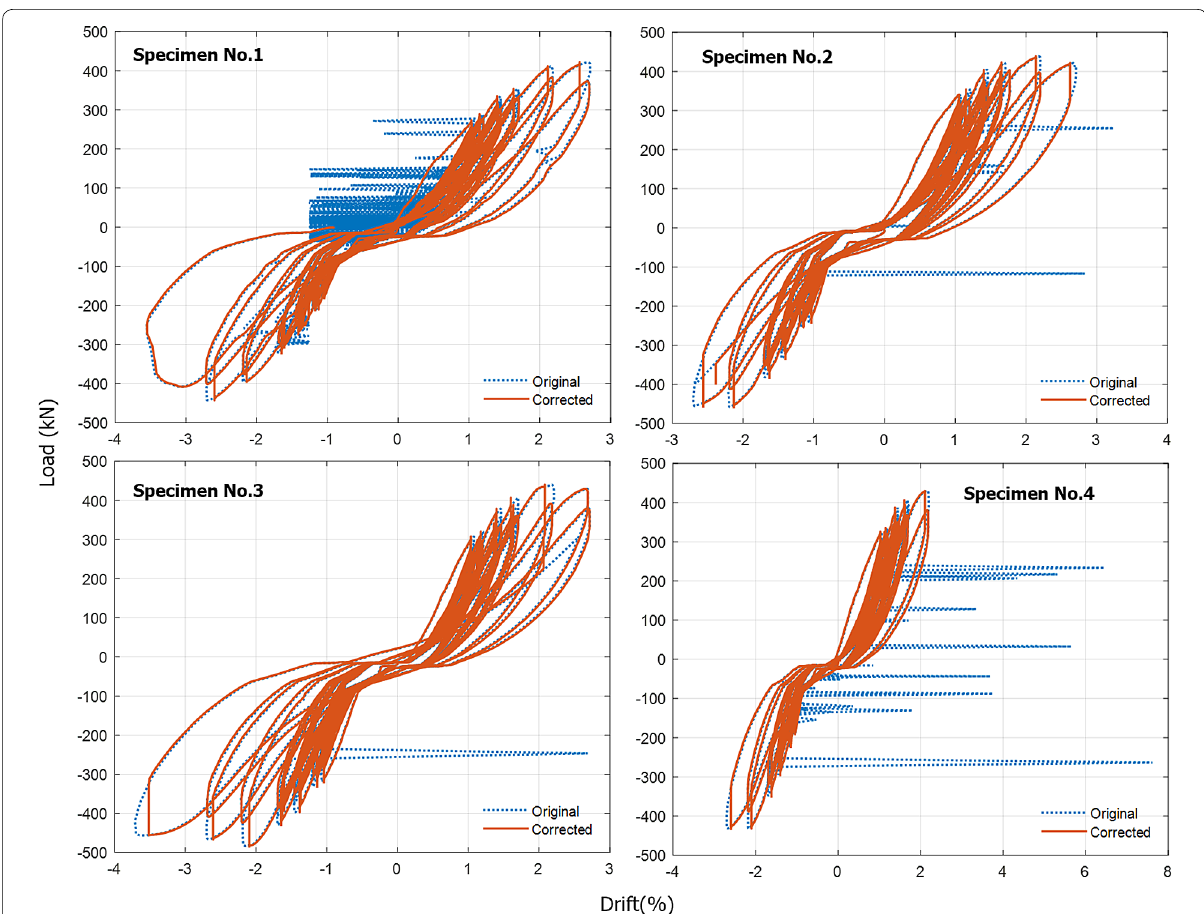
Fig. 16 Corrected test data in comparison with the original test